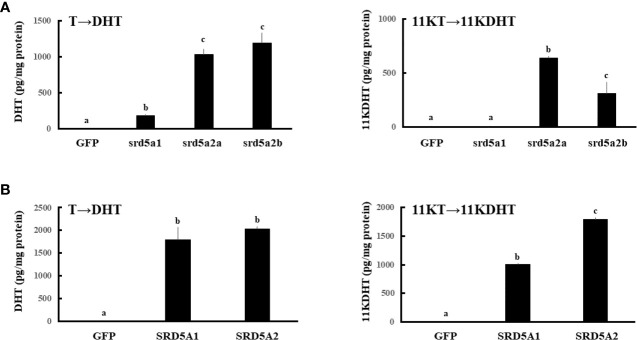
Evaluation of the enzymatic activities of eel srd5a (A) and human SRD5A (B). Expression vectors of each gene were transfected, and 24h after transfection, cells were incubated with T (1 nM) or 11KT (1 nM) for 3h. Concentrations of DHT and 11KDHT in culture media were analyzed by LC-MS/MS. Each column represents the mean ± SEM (n =3 for each group) of three independent experiments. Values marked by different letters are significantly different (P< 0.05).